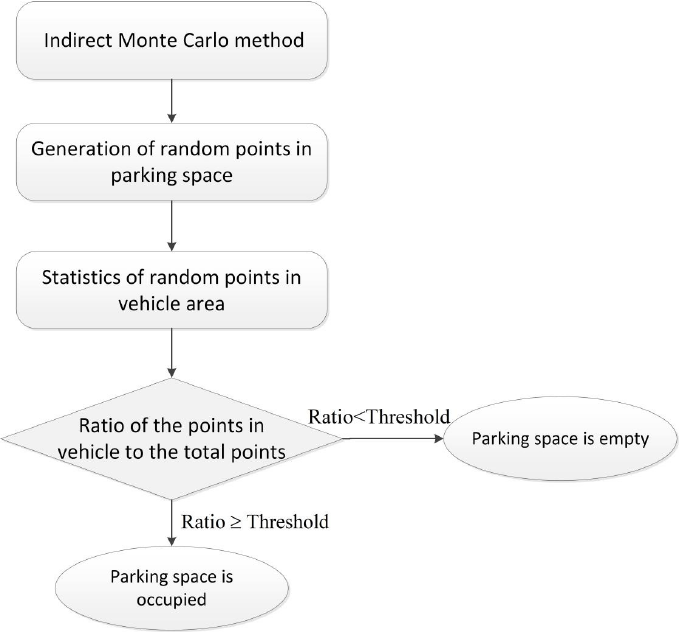
Figure 9. Flowchart for the judgment of the parking space module.